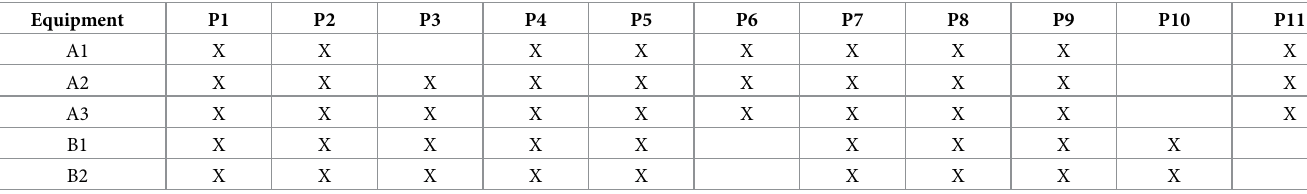
Table 7. Types of products which can be process on each machine technology.